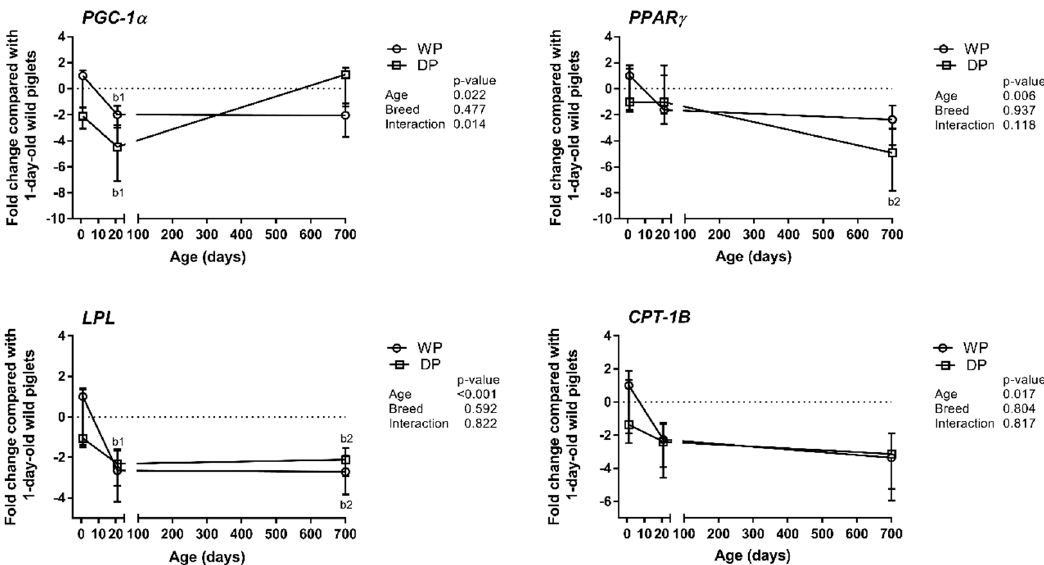
Figure 2. Age- and breed-dependent changes in lipid metabolism-related gene ( PGC-1 α , PPAR γ , LPL, and CPT-1B ) expression in the longissimus dorsi muscle of wild pigs (WPs) and domestic pigs (DPs). Shown are the mean fold changes with upper and lower limits in lipid metabolism-related genes expression for WPs and DPs compared with the expression in 1-day-old wild piglets. A fold-change value less than 1 was replaced by a negative inverse of the original fold-change value. Upper and lower limits were calculated for each fold-change value using the standard error of the mean. Effect ( p -Values) for age, breed, and their combined effect (age × breed interaction) were derived by two-way analysis of variance. Differences were considered significant at p < 0.05 (Tukey’s multiple comparisons tests). a -significantly different between breeds within an age group; b1 -significantly different between 1-day-old wild piglets and 3-week-old pigs; b2 -significantly different between 1-day-old wild piglets and 2-year-old pigs.